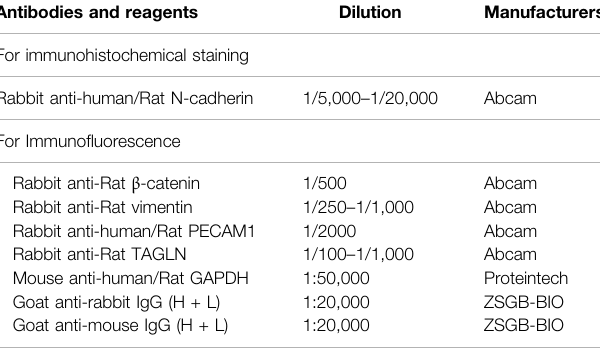
TABLE 2 | Antibodies and other